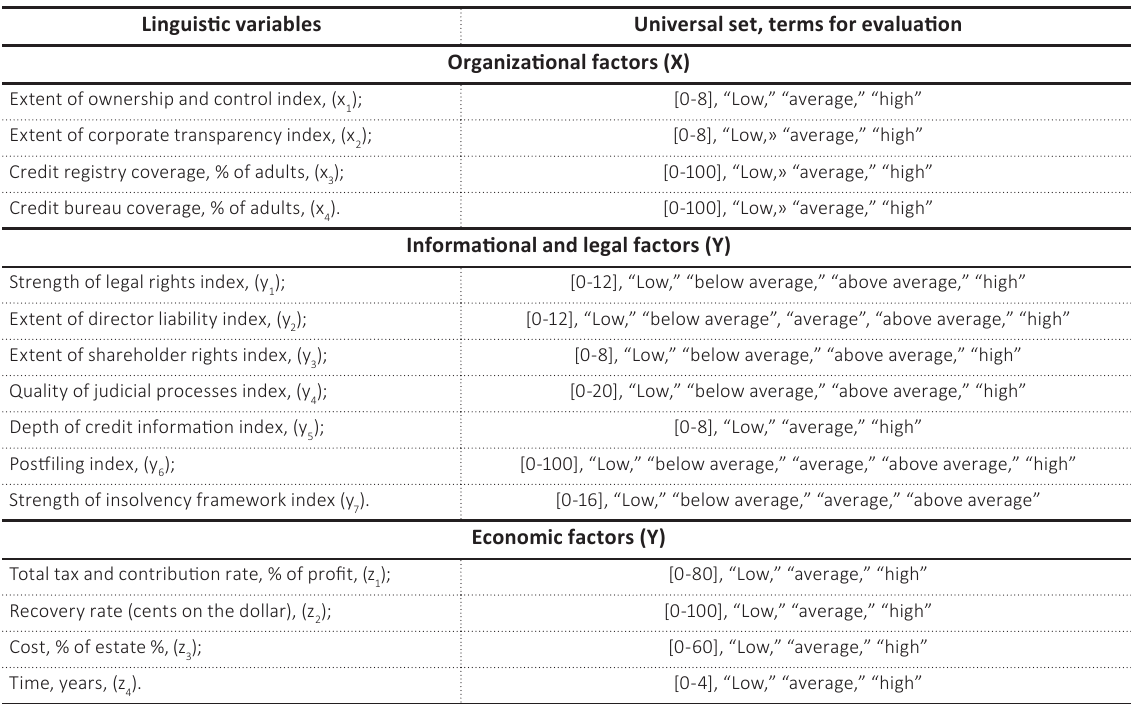
Source: Authors’ elaboration.